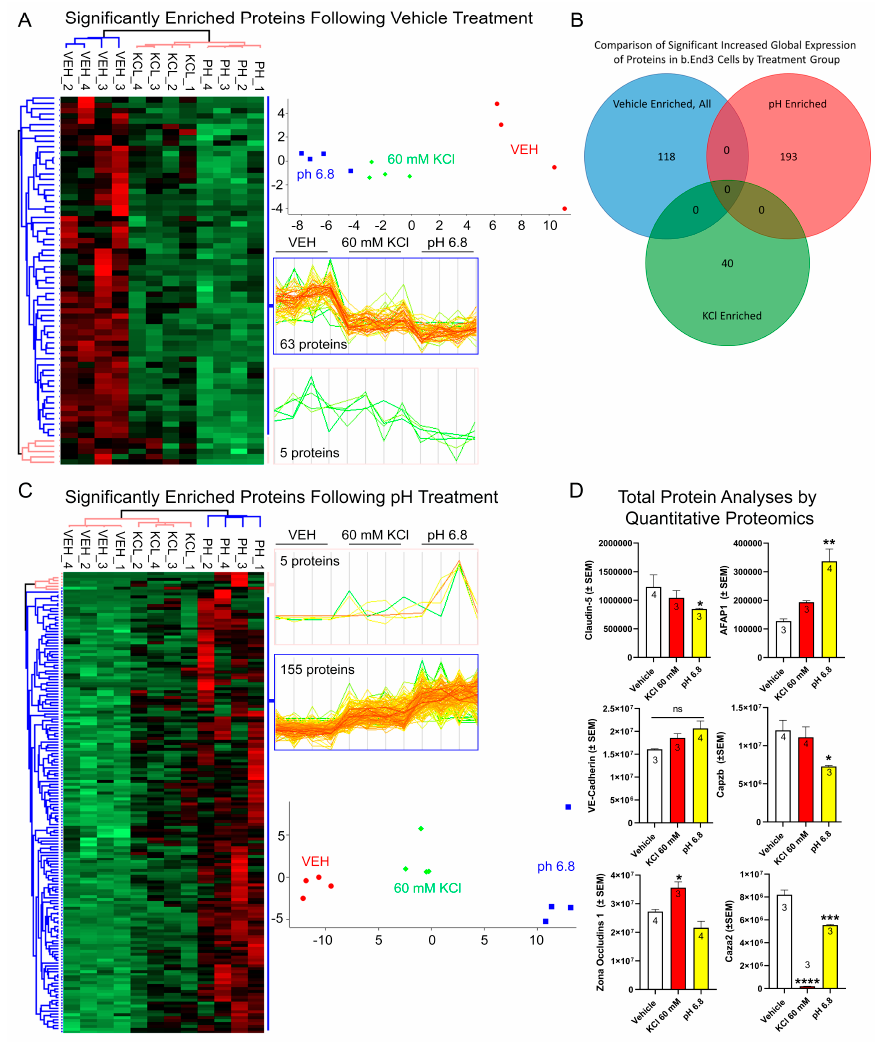
Figure 4. Global unlabeled quantitative proteomics analysis of b.End3 endothelial cells demonstrate convergent effect of independent mechanisms resulting from vehicle, 60 mM KCl, and media